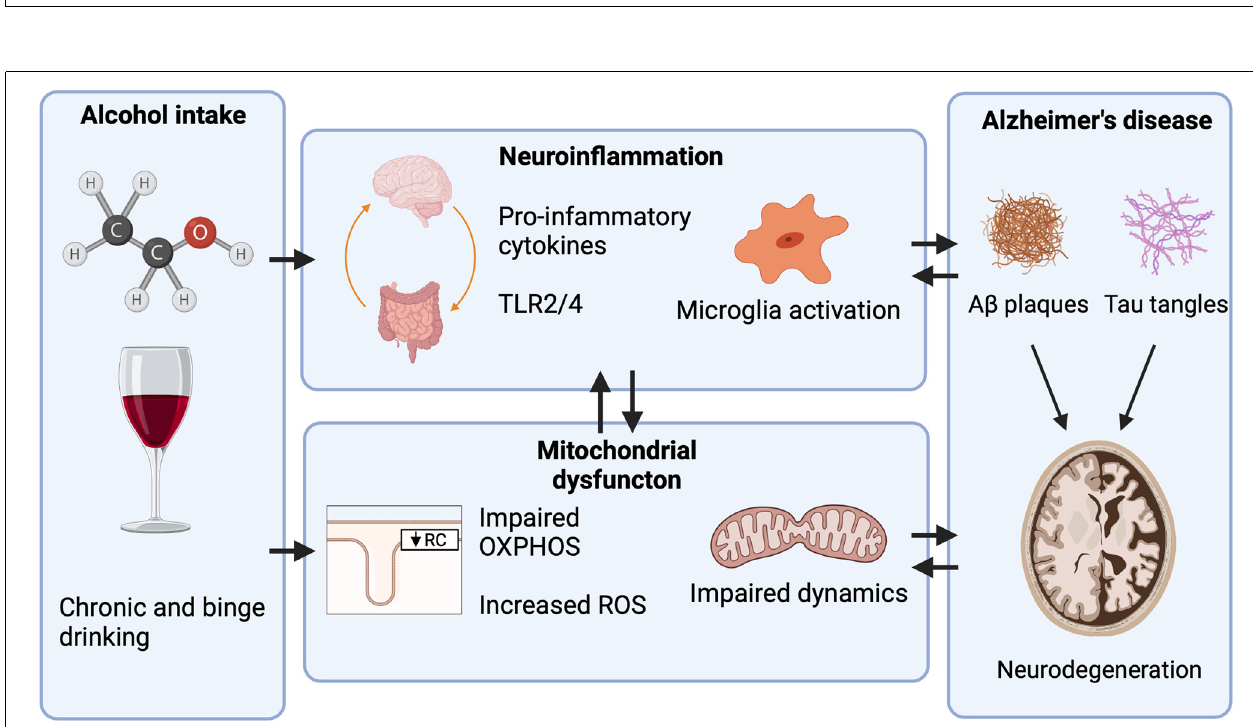
FIGURE 2 | Mechanisms through which heavy alcohol abuse increases the risk for Alzheimer’s disease (AD). Only heavy alcohol abuse increases the risk for AD while light and moderate Alcohol use do not. Proposed mechanisms through which heavy alcohol abuse may increase the risk for AD. Alcohol increases peripheral inflammation by increasing the gut translocation of lipopolysaccharide (LPS) into circulation, where it activates peripheral immune cells and increases pro-inflammatory cytokine release. Pro-inflammatory cytokines then cross the blood-brain barrier (BBB) activating microglia and astrocytes. In the CNS, alcohol increases the expression of toll-like receptor 4 (TLR4) and High mobility group box 1 (HMGB1), a ligand for TLR4. TLR4 activation leads to NF- κ B induction of pro-inflammatory cytokine release which further activates other microglia and astrocytes. Heavy alcohol abuse also impairs mitochondrial function by impairing OXPHOS, increasing the generation of ROS, and impairing mitochondrial dynamics. As neurons are energetically demanding cells, mitochondrial dysfunction is a contributing factor to neurodegeneration.